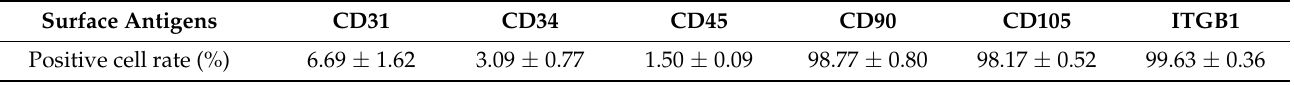
Table 1. Flow cytometry analysis of surface antigens in